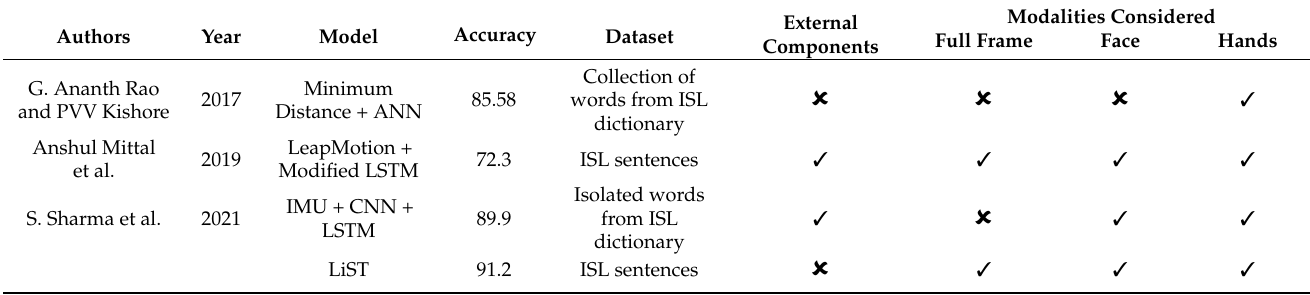
Table 4. Accuracy comparison between LiST and other benchmark